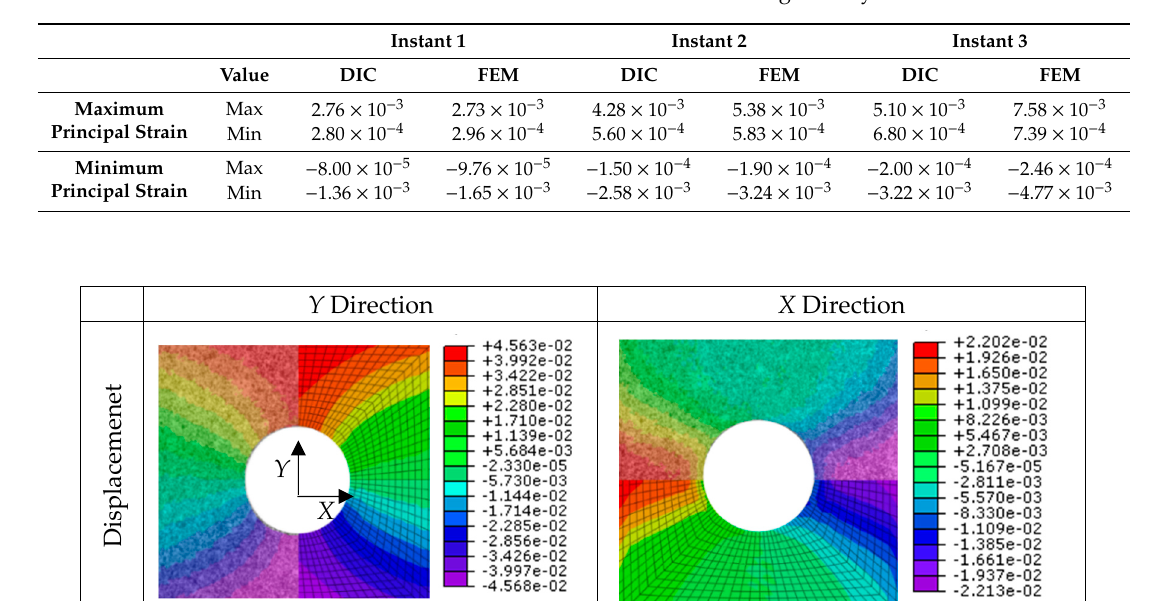
Table 8. Maximum and minimum strain values for geometry B.